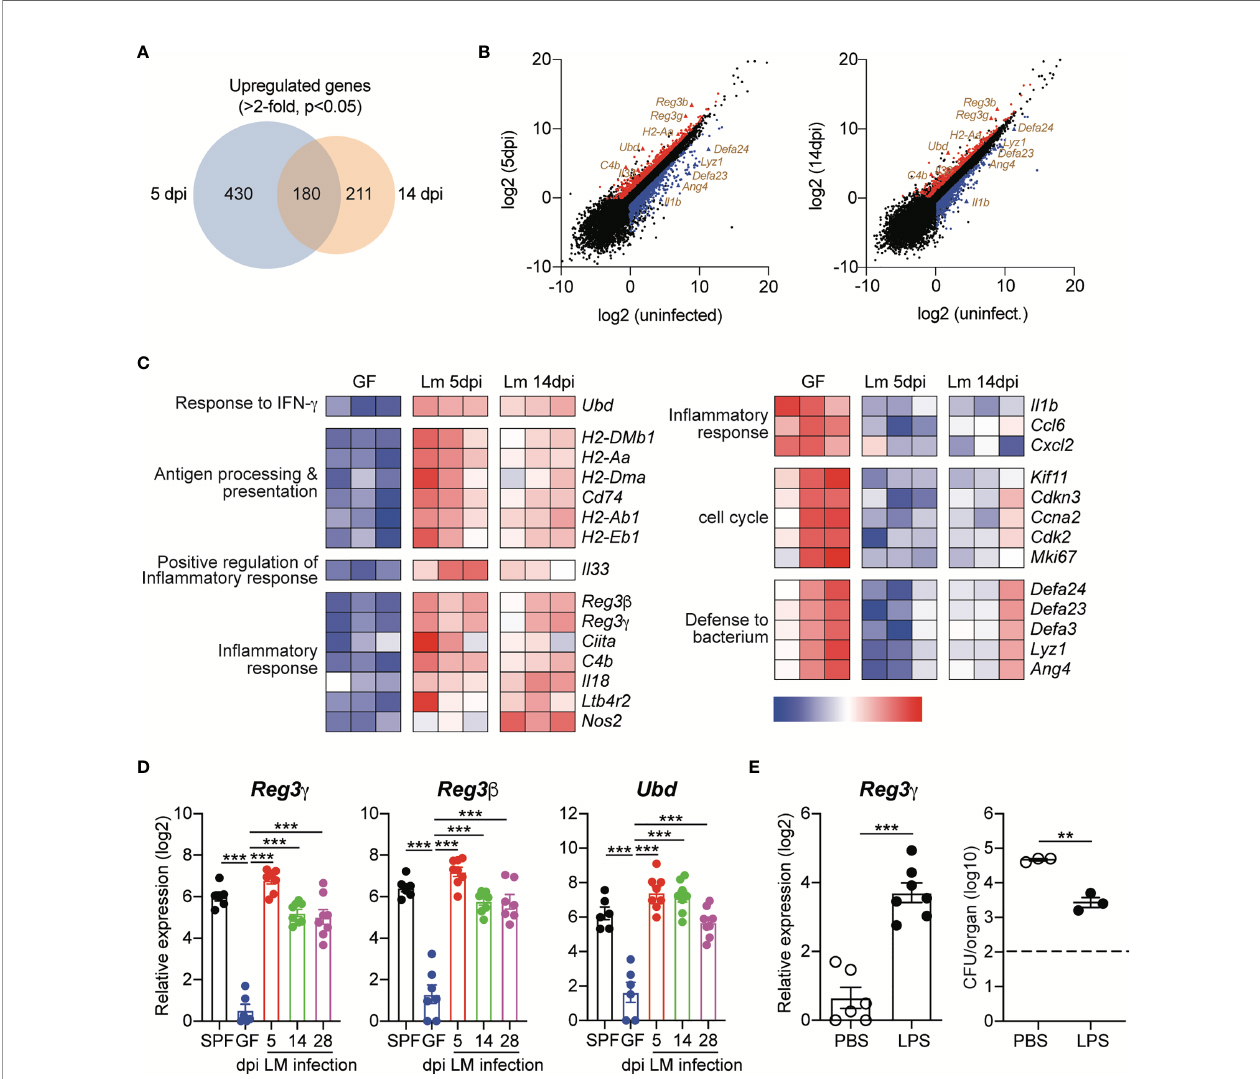
FIGURE 4 | OralInfection with L.monocytogenes Induces Prolonged Upregulation ofAntimicrobialProtein Expression in Intestinal Epithelial Cells. Smallintestinal epithelial cells (IECs) from GF mice were collect at indicatedtime points after InlA m LM-OVA infection and then subjected to RNA-seq gene expression analysis. Differentially expressed genes (DEGs) were identi fi ed using three independent comparisons; uninfected vs . 5dpi, uninfected vs . 14dpi, and5dpi vs . 14dpi. (A) The Venndiagramsshowingthe overlap between upregulated genes in IECs from infectedGFmice at 5 dpi and 14 dpi relative to gene expression in IECs from uninfected GFmice. (B) Volcano plot of RNA- seq transcriptome data displayingthe patternof gene expression values for IECs at5 dpi and 14 dpi vs . uninfected IECs. The differentially expressed genes (FDR < 0.05 and log2 fold change > 1)are shown.Upregulated or downregulated genes are indicated byred or blue color,respectively. (C) Heat map showingdetailed expression information in IECs from uninfected GF,GFinfectedwith InlA m LM-OVA at 5dpi and14dpi. Each column represents an individual mouse (n=3 per group). (D) TotalRNA was prepared fromIECs ofuninfected SPFand GF mice, and InlA m LM -OVA infected GF mice at indicated time points. Expression of Reg3g , Reg3b , and Ubd was measured by qRT-PCR. Data are pooled fromtwo independent experiments (n=6~8 per group). (E) GF mice were i.p.injected with PBS orLPS (20 m g per mouse) for 3 consecutive days andthen infected with InlA m LM -OVA. At 5 dpi,IECs were sorted to examinethe expression of Reg3g gene (n=6 per group) and to measure tissue-in fi ltrating bacteriainmLN (n=3 per group). Reg3g geneexpression (left) and bacterialoadsin mLN (right). Statistical differences were determined byone-way ANOVA with Tukey ’ s multiple comparisonsor unpaired two-tailed Student ’ s t test. **P < 0.01,